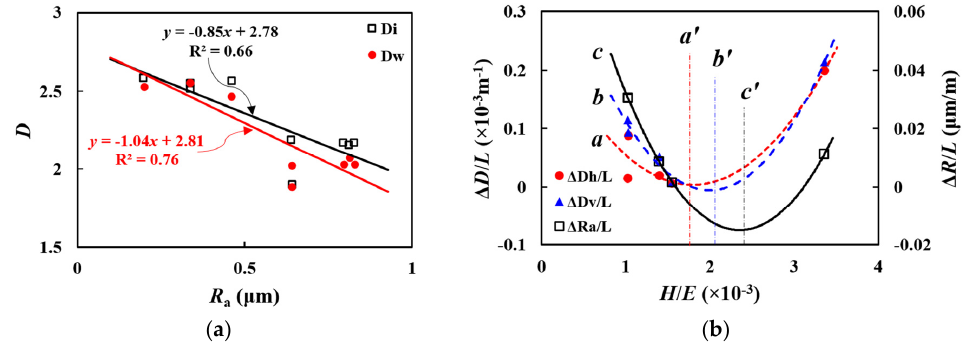
Figure 6. Illustration of: ( a ) Relation of average surface roughness and fractal dimension; and ( b ) comparison of the change rates after wear in the unit sliding distance (1